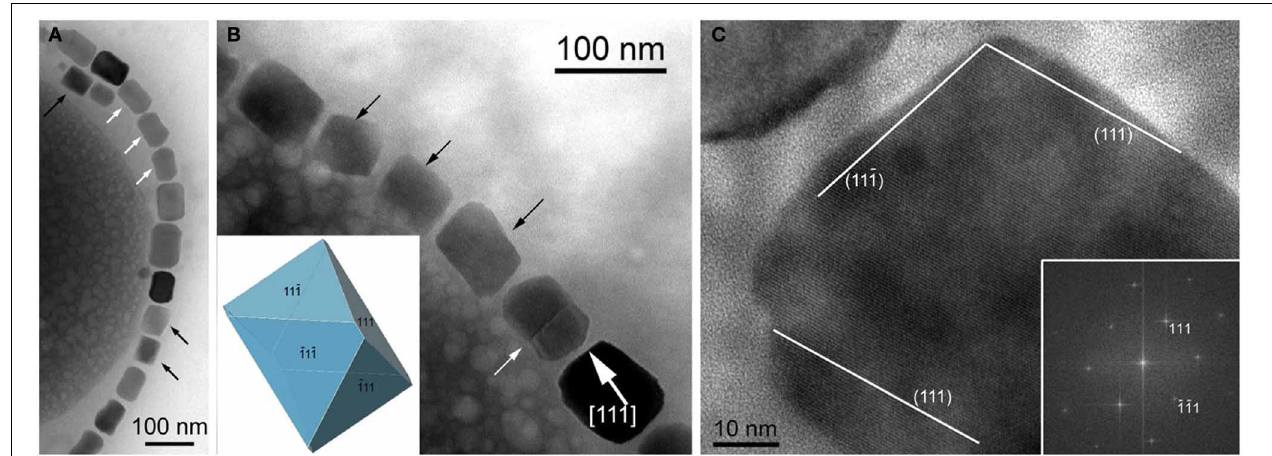
FIGURE 2 | Magnetite magnetosomes with elongated octahedral habits in the magnetotactic Gammaproteobacteria strain SS-5. (A) TEM image of a chain of highly elongated magnetosomes. Black arrows mark crystals with pronounces octahedral facets, and white arrows point to magnetosomes with a “waisted” appearance, probably a result of twinning. (B) TEM image of part of a magnetosome chain with elongated octahedral habits (marked by black arrows and modeled in